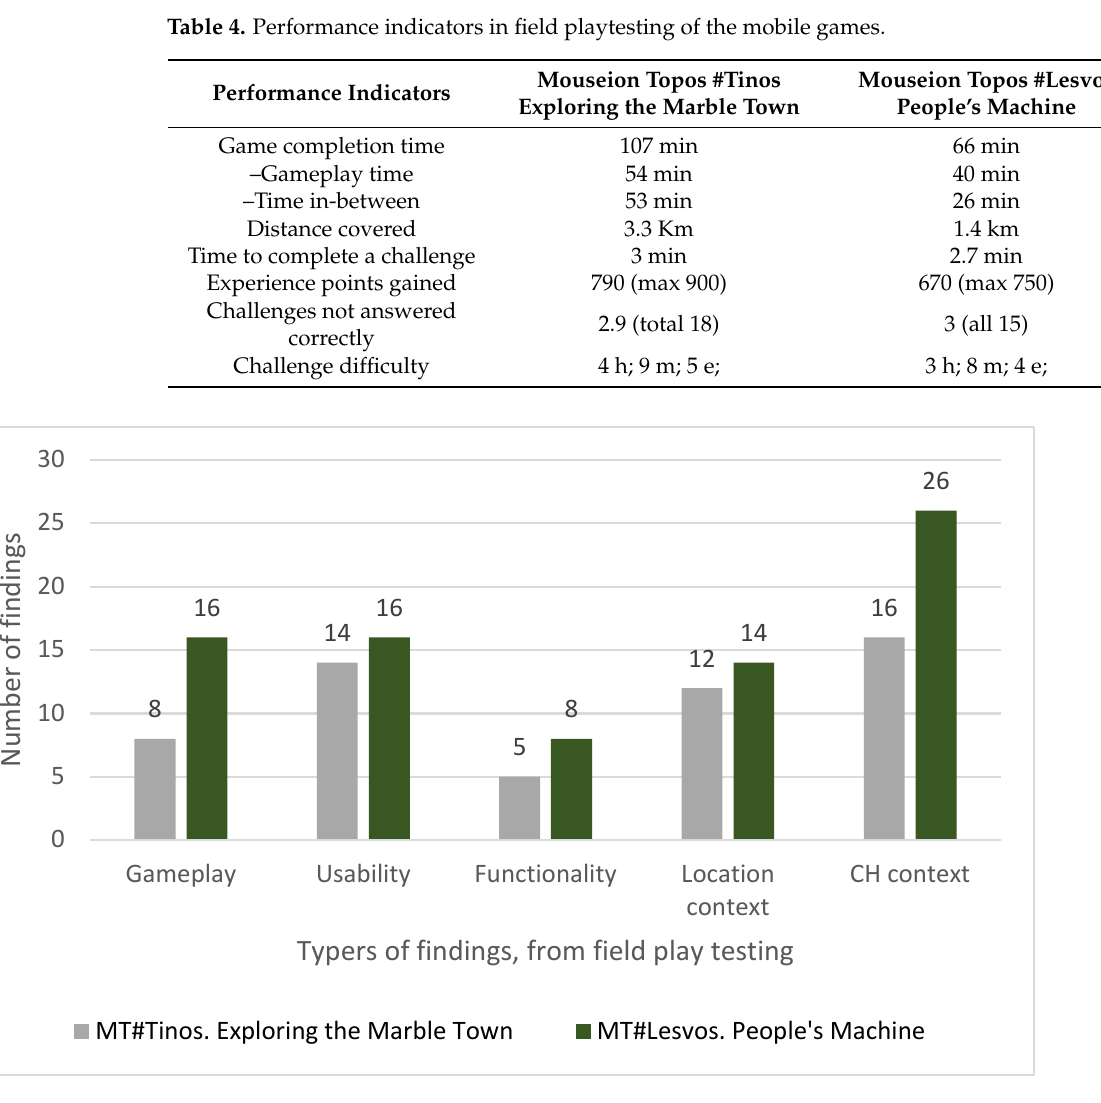
Figure 7. Overview of findings from field playtesting of the mobile games.